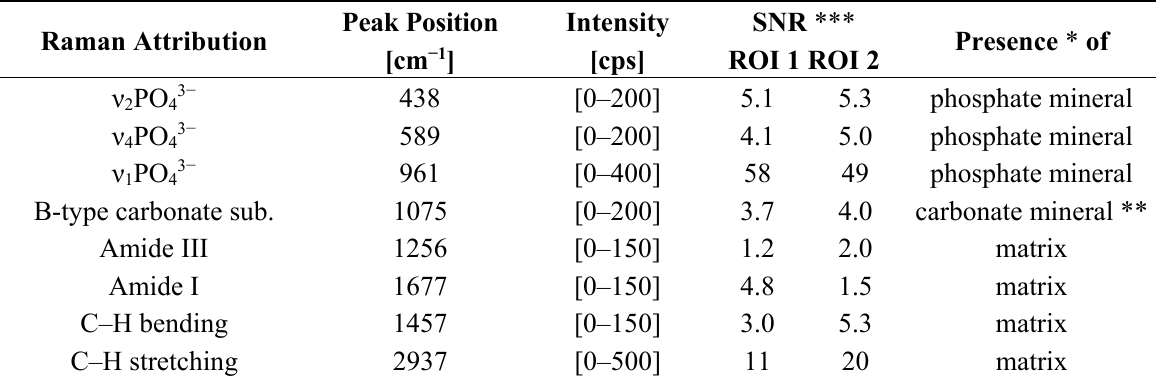
Table 1. Selected Raman bands of bone [21,23,36] and their intensity ranges for optimum Raman image contrast